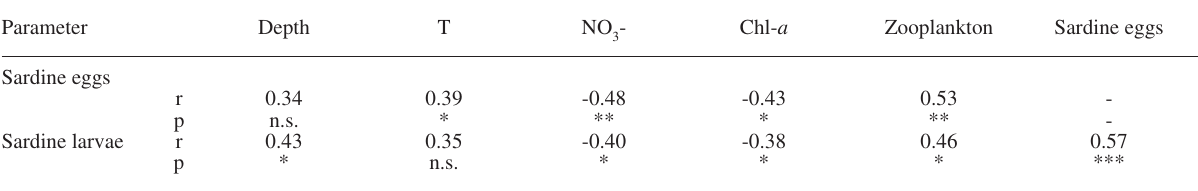
Table 1. – spatial correlations between sardine egg and larval abundance and environmental parameters in winter; r: correlation coefficient and p: probability with n.s. (p>0.05); * (p<0.05); ** (p<0.01); *** (p<0.001). Parameter sardine eggs